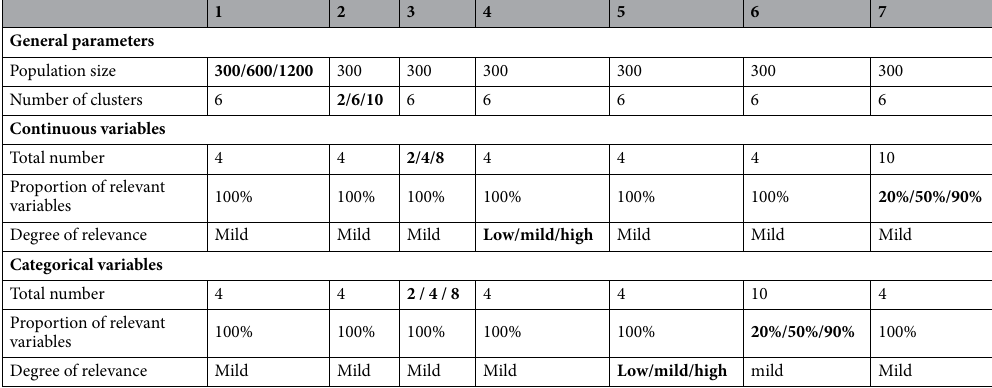
Table 2. Parameters of the simulated populations according to each tested